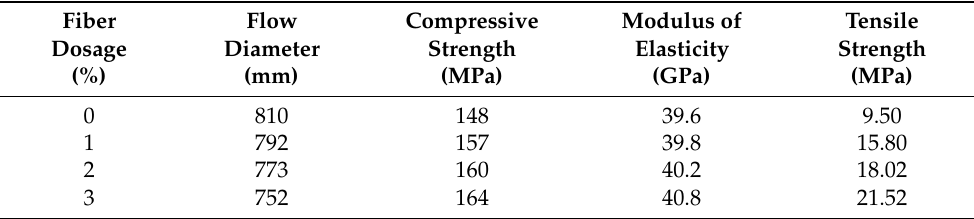
Table 4. Flow and mechanical properties of UHPC mixtures.